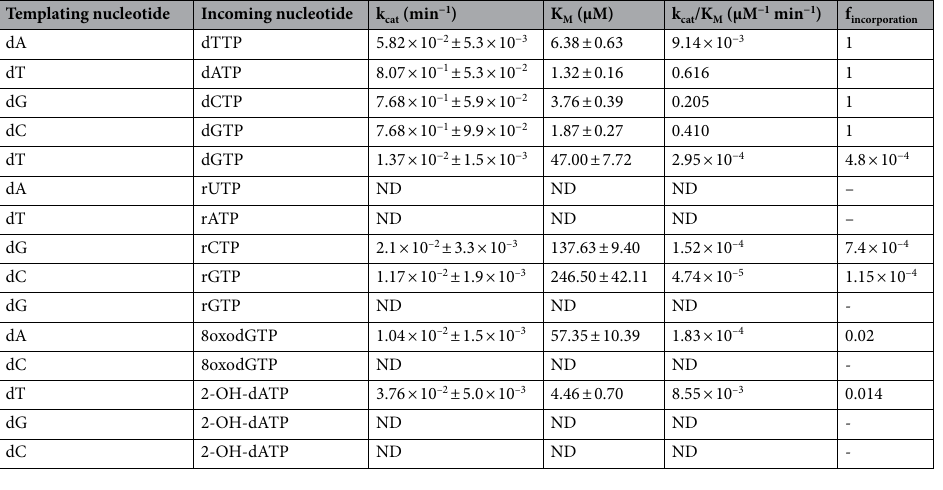
Table 1. Steady-state kinetic parameters for nucleotide incorporation by exonuclease mutant saPolX- H435A on 1 nucleotide gapped DNA substrates. For each combination, the templating position nucleotide is mentioned in column 1 and the incoming nucleotide is mentioned in column 2. Not determined is abbreviated as